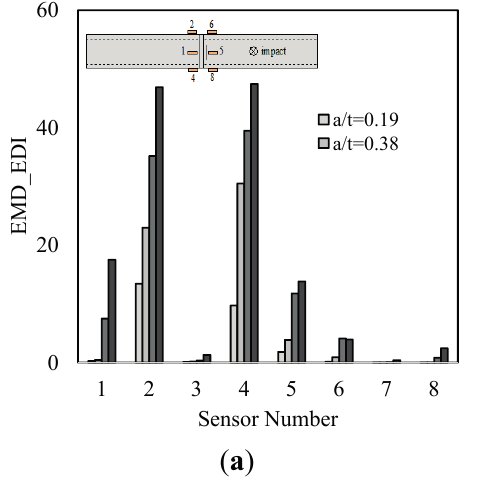
Figure 9. Damage indices obtained from the impact test: numerical (( a ) and ( b )) and experimental study (( c ) and ( d )). Note that a/t is the ratio of notch’s depth to pipe’s wall